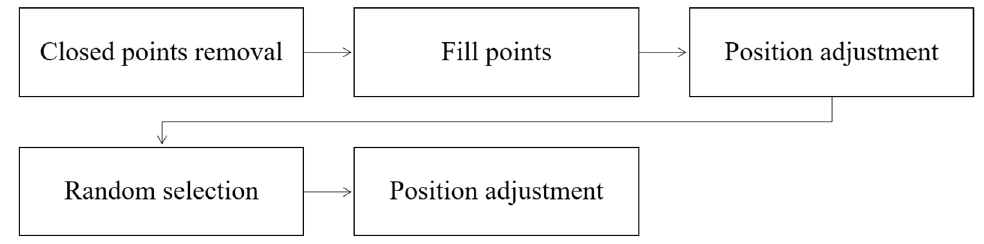
Figure 3. Flow of data resampling after normalization.